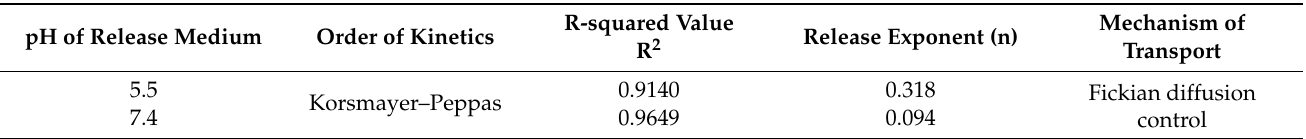
Table 2. R-squared and release exponent (n) values acquired from the kinetic study.